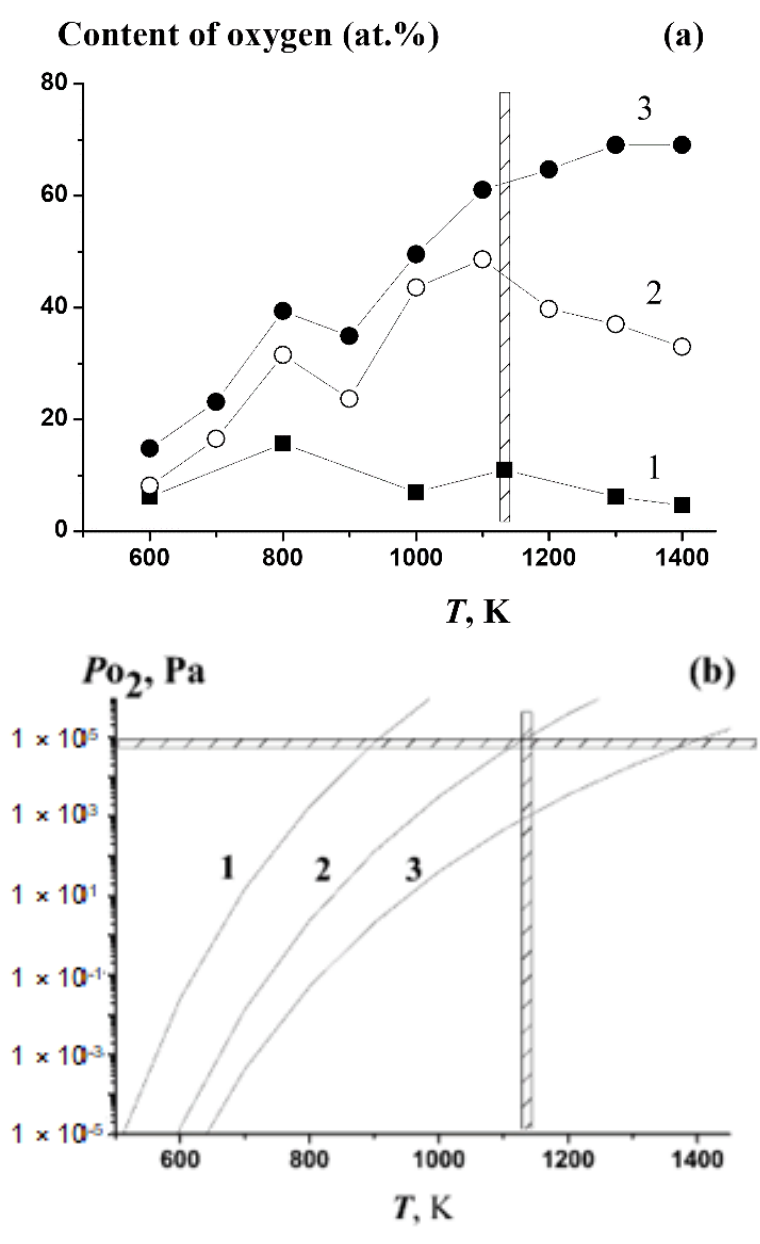
Figure 2. ( a ) Dependences of oxygen concentration on the temperature of treatment in O 2 for 3 h at P o 2 = 2.1 × 10 4 Pa for Pt(poly) (1), and P o 2 = 10 5 Pa for Pd(poly) (2) and Rh(poly) (3) according to EDS data. ( b ) Temperature dependencies of equilibrium O 2 pressure during dissociation of PtO 2 (solid) (1), PdO(solid) (2) and Rh 2 O 3 (solid) (3). The vertical dotted marker indicates the temperature of 1133 K, and the horizontal one — Р о 2 equal to 6.8 × 10 4 Pa.